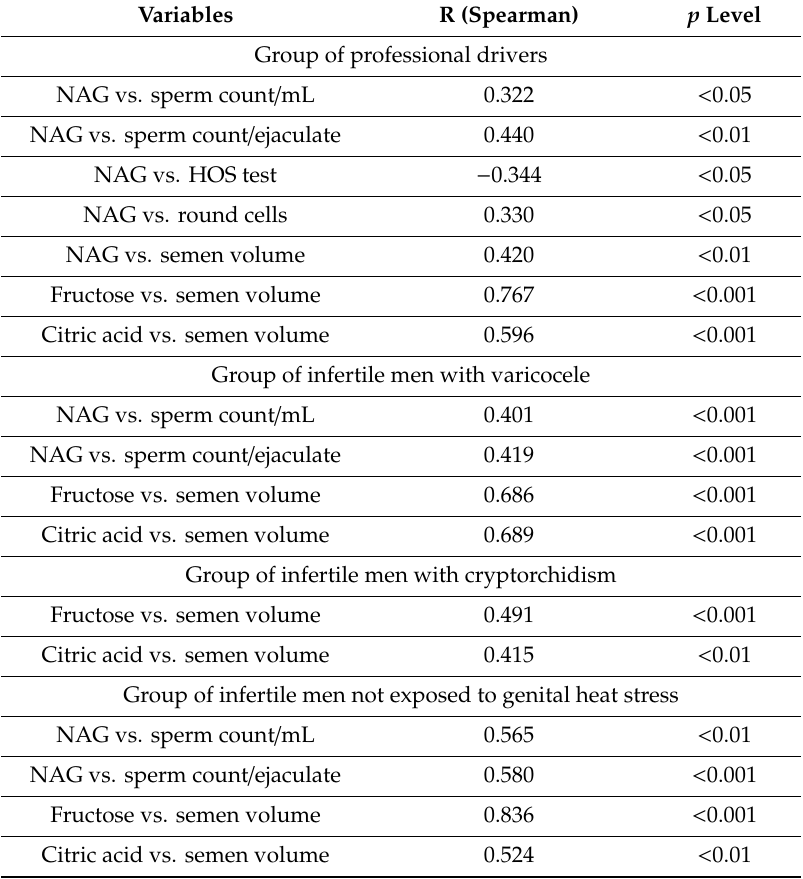
Table 1. Spearman rank order correlations between biochemical parameters and standard semen characteristics in the studied